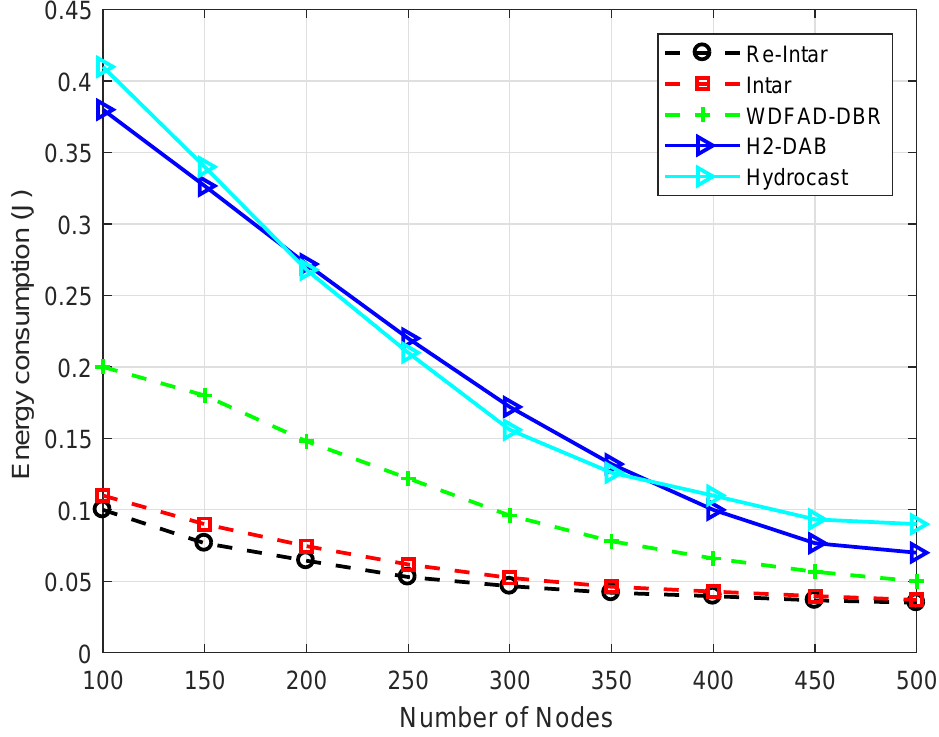
Figure 5. Energy tax of the existing and proposed protocols with varying number of